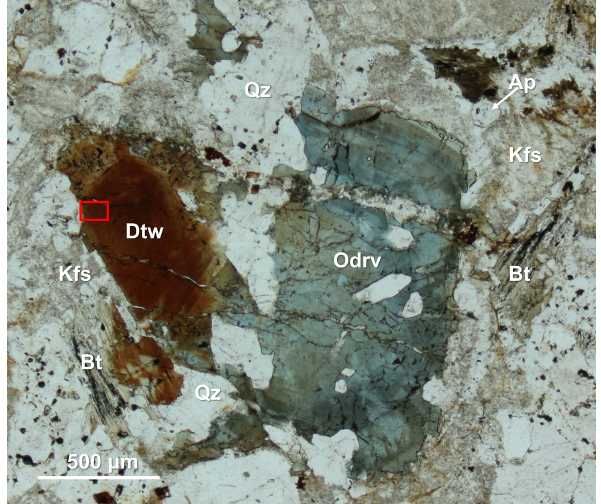
Figure 1. Photomicrograph of dutrowite in plane-polarized light.